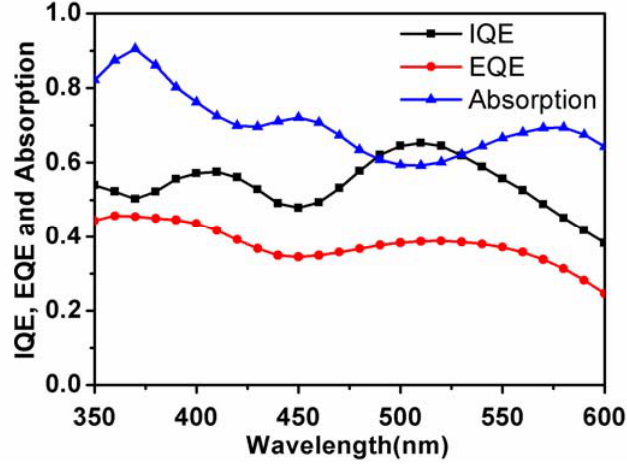
Table 3. Photovoltaic performances of D149 based bilayer OPV devices based on a structure of ITO/Hole transport layer/D149 (8 nm)/C different electron- and hole-transport